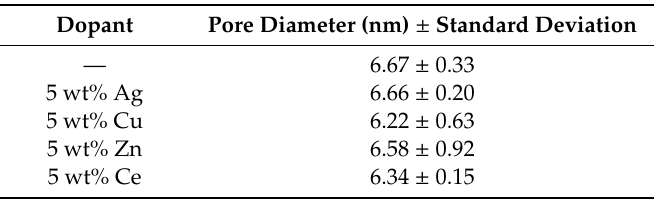
Table 1. Average pore diameters of ordered MSGs.